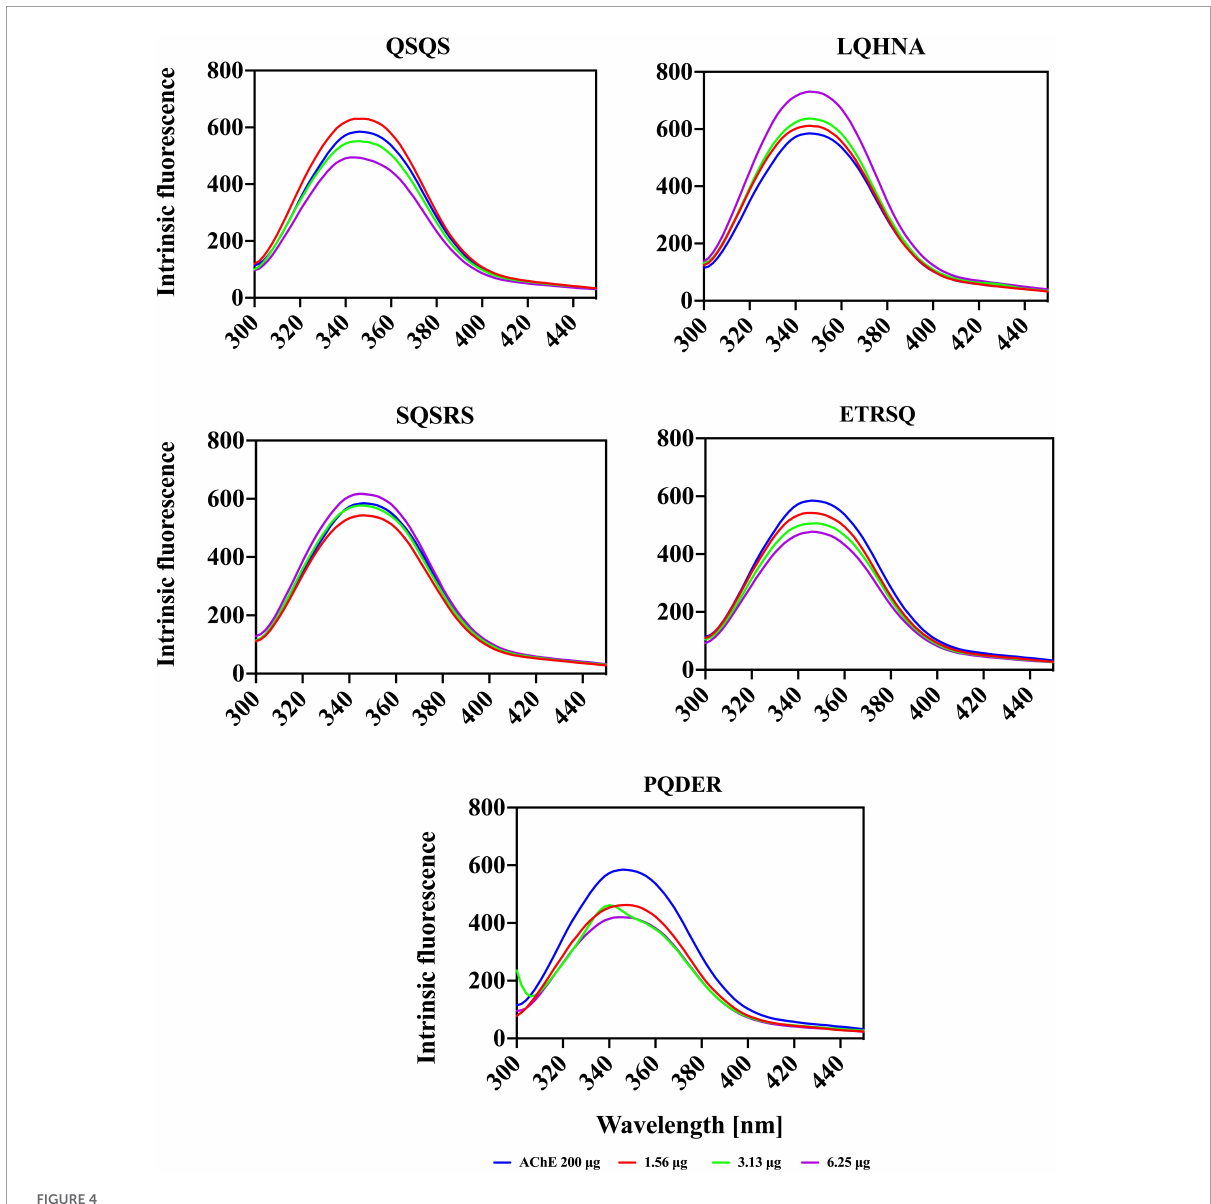
FIGURE4 Fluorescence intensity spectra of AChE in the absence and presence of peptides.